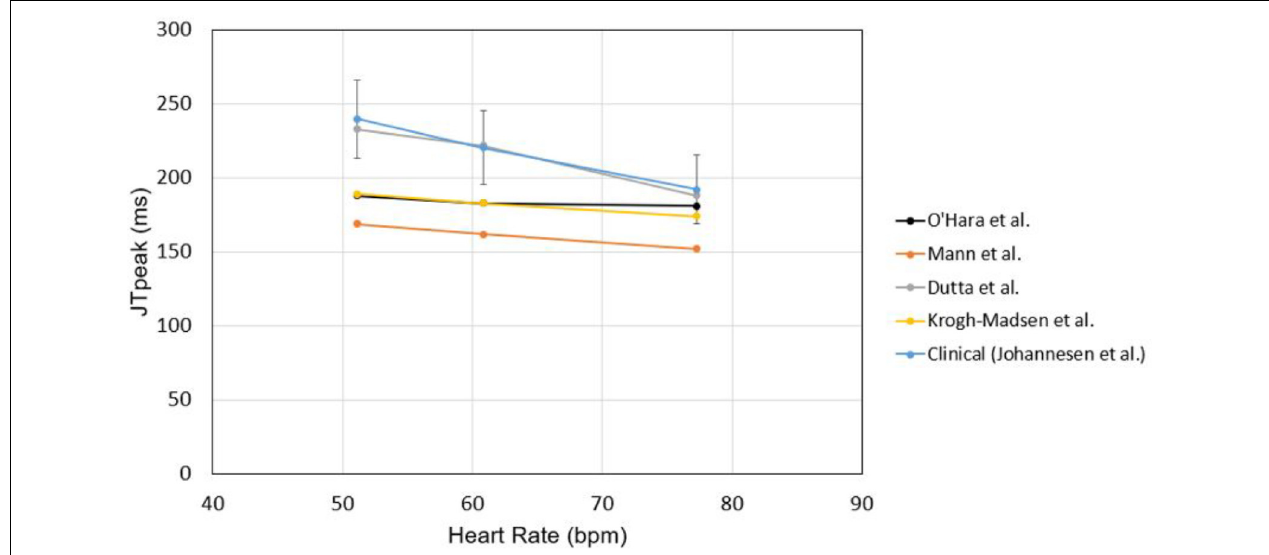
FIGURE 7 | Rate dependence of JTpeak. JTpeak was obtained for different heart rates with different cell models. Simulation results were compared with clinical data by Johannesen et al.